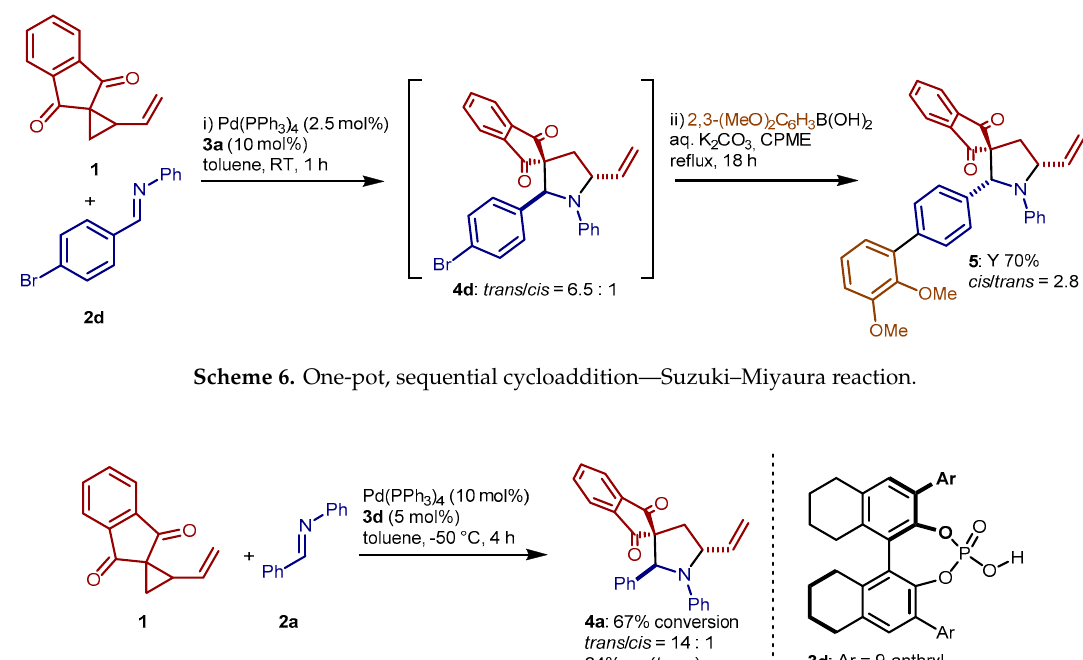
reaction between VCP 1 and imine 2a